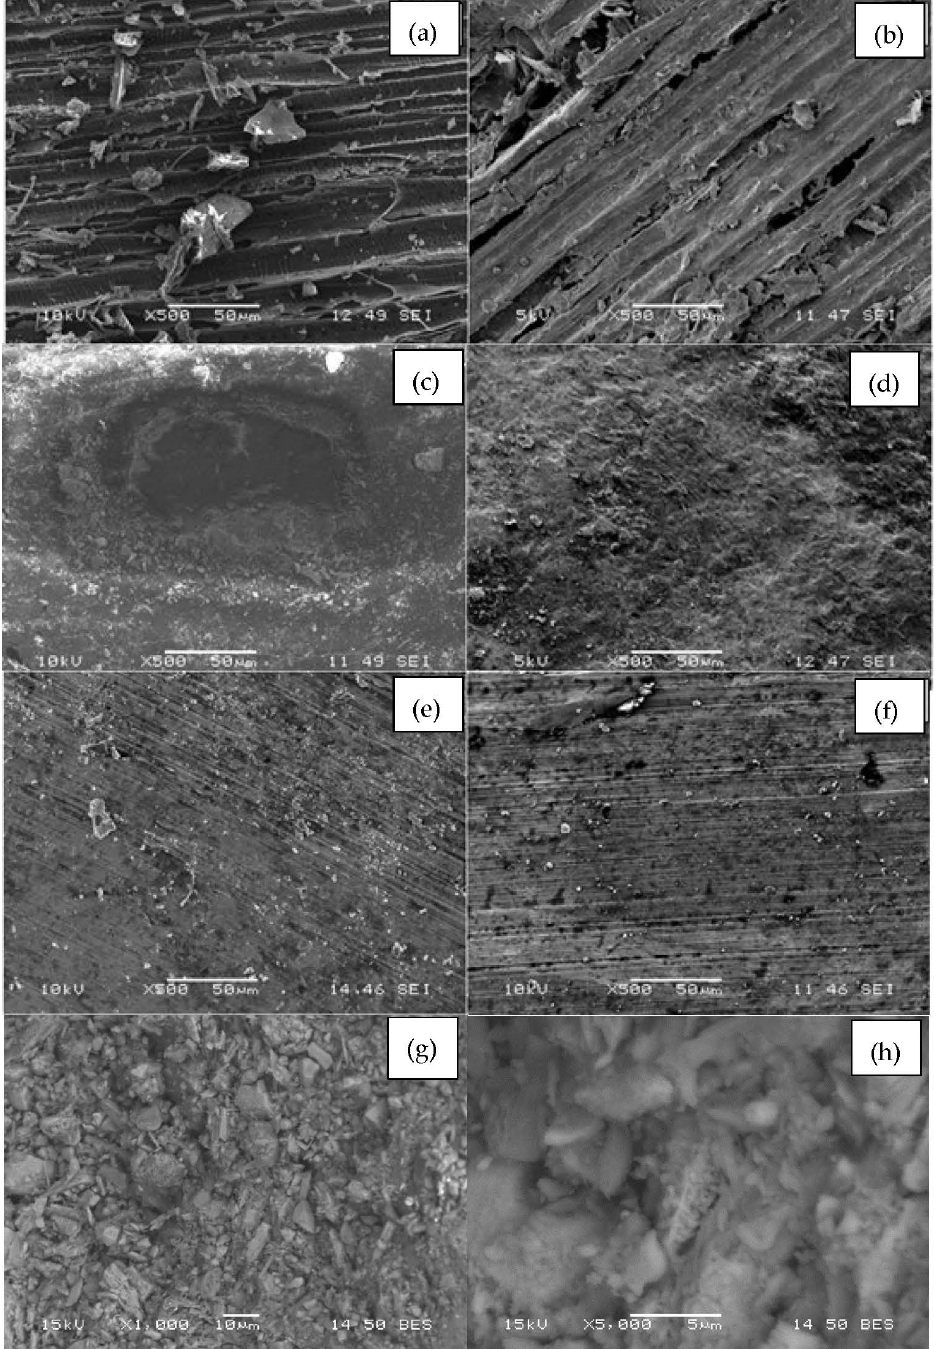
Figure 1. SEM images of each material’s surface taken at 500 × magnification of: ( a ) raw buckthorn; ( b ) MGBC, ( c ) raw mussel shell; ( d ) CSHELL; ( e ) raw steel; ( f ) PSTEEL; ( g , h ) SLAG.